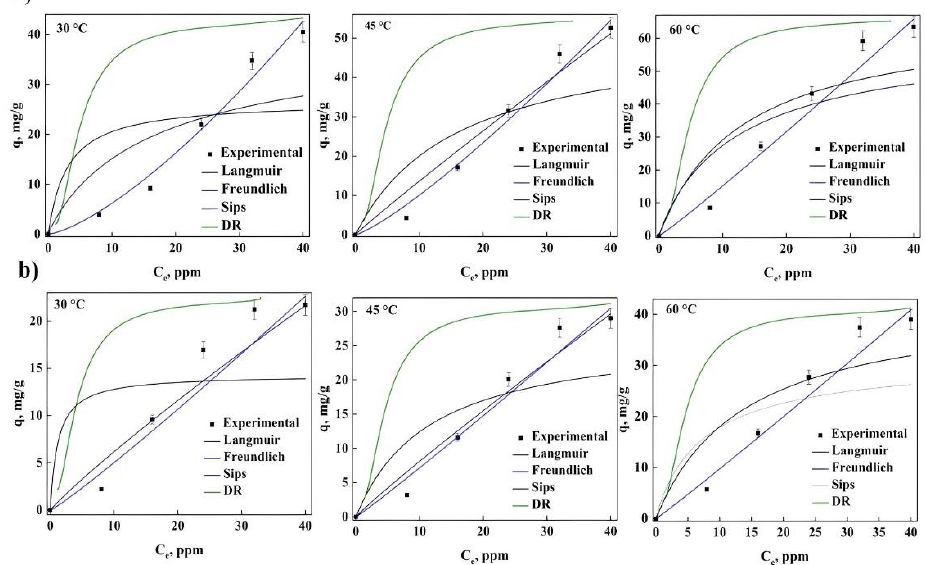
Figure 4. Fitting for the experimental data of the adsorption of GV at different temperatures using different isotherm models: ( a ) WLW and ( b ) NWL.